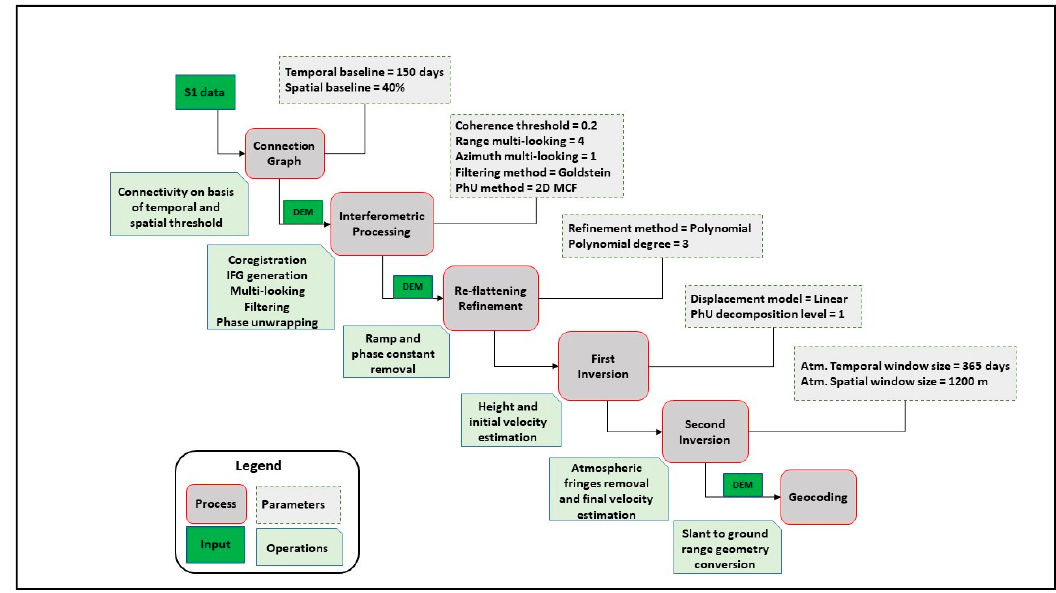
Figure 4. SBAS algorithm workflow for deformation studies. PhU refers to phase unwrapping, IFG to interferograms, MCF to minimum cost flow, Atm. to atmospheric.